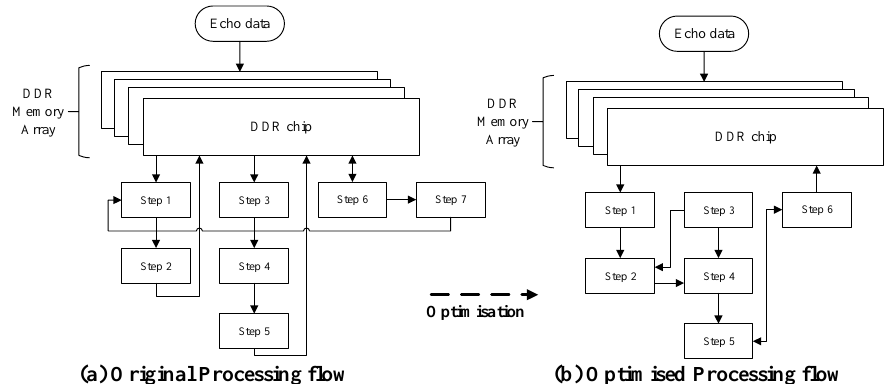
Figure 6. Algorithmic flow optimisation.